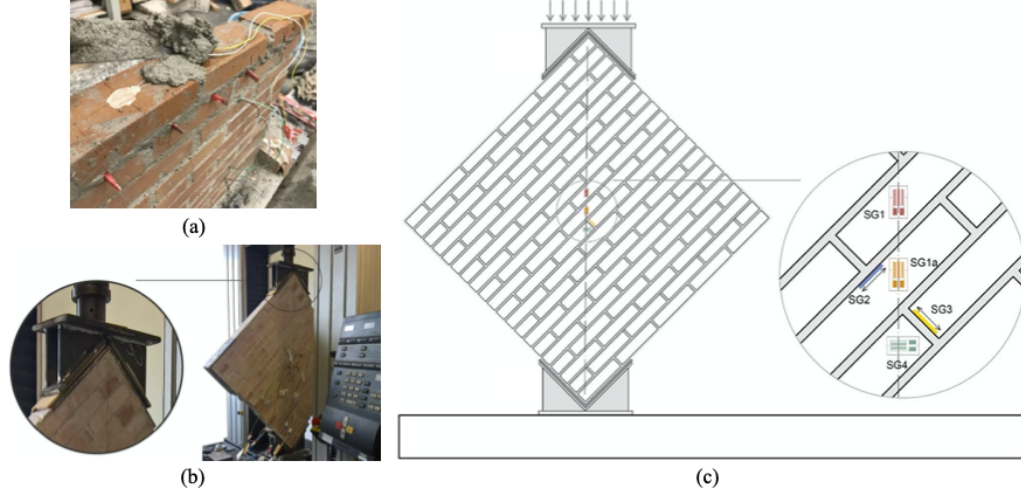
Figure 5: Realization (a) and diagonal test setup (b, c) of a reduced-scale masonry panel, together with sensors placement. The strain gauges SG1a and SG4 are read with the proposed low-cost